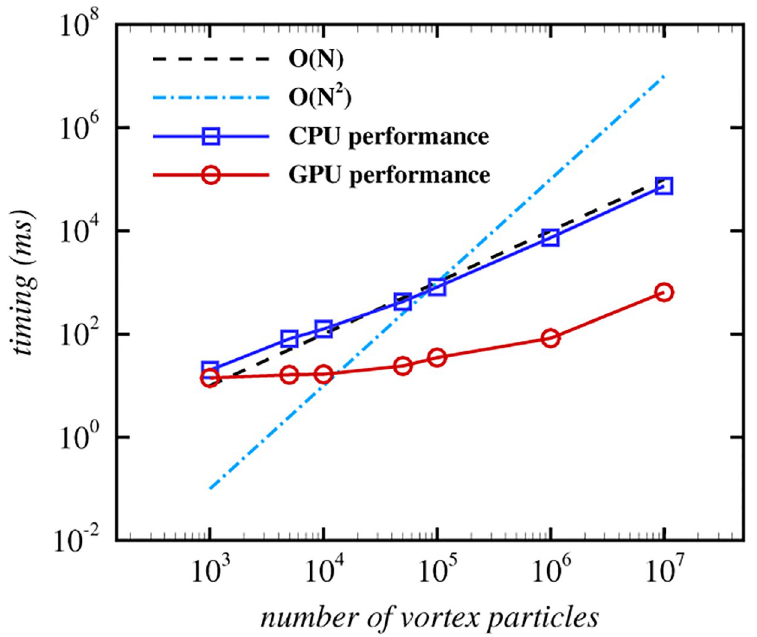
Fig 8. Performance of the nested grid